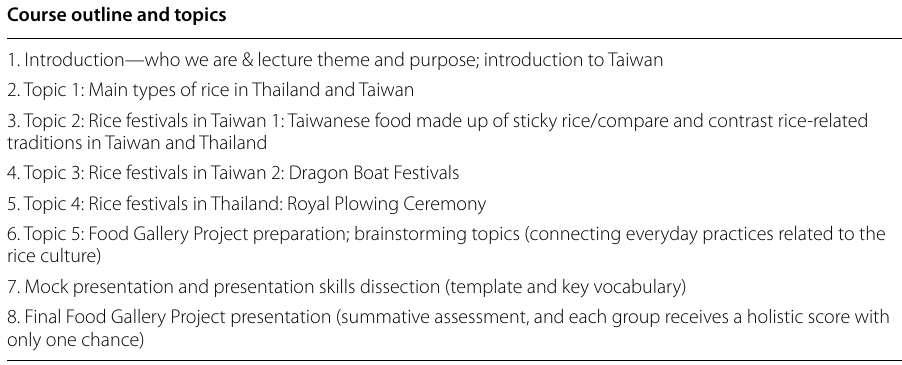
Table 2 Syllabus of “A Rice and Culture Tour in Taiwan and Thailand” Course outline and